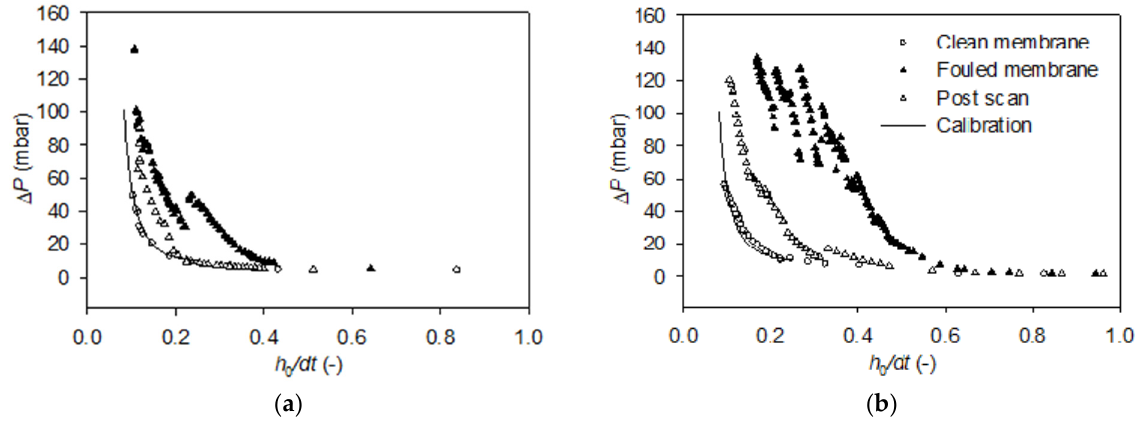
Figure 5. FDG pressure drop vs relative distance, h 0 /dt , profiles for fouling experiments with low surface charge ( a ) and high surface charge ( b ) PS–PAA microparticles with calcium ions. Clean membrane measurements have been used to determine offsets which have been applied on the “fouled membrane” and “post-scan” data series.